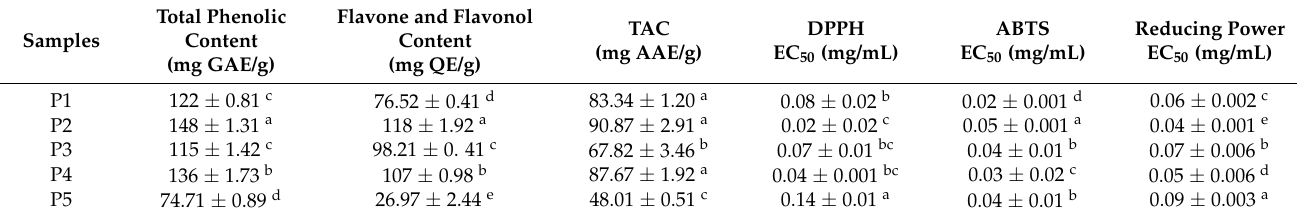
Table 4. Total phenolic content, flavone and flavonol content, TAC, and antioxidant activities of propolis samples.